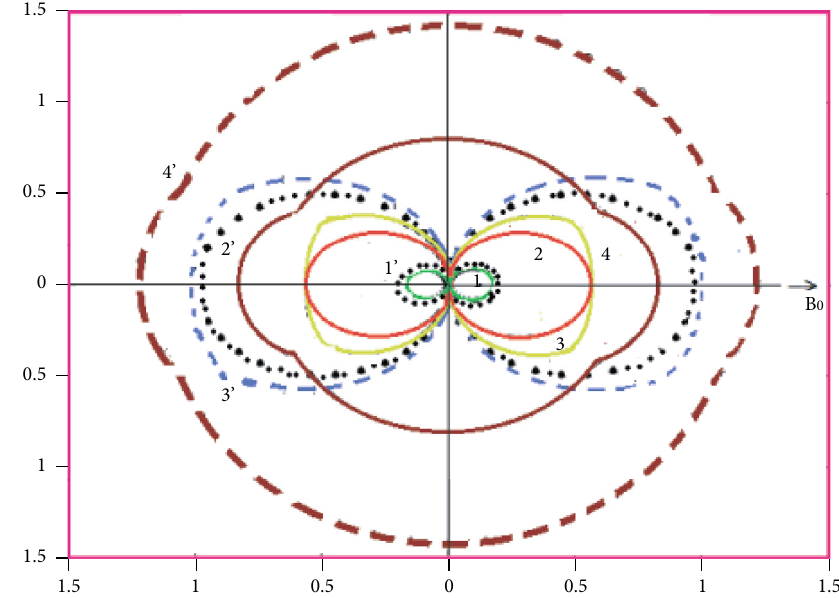
: 9, b 2 b 2 A = 0 ⊥ 1 = ∥ 1 =